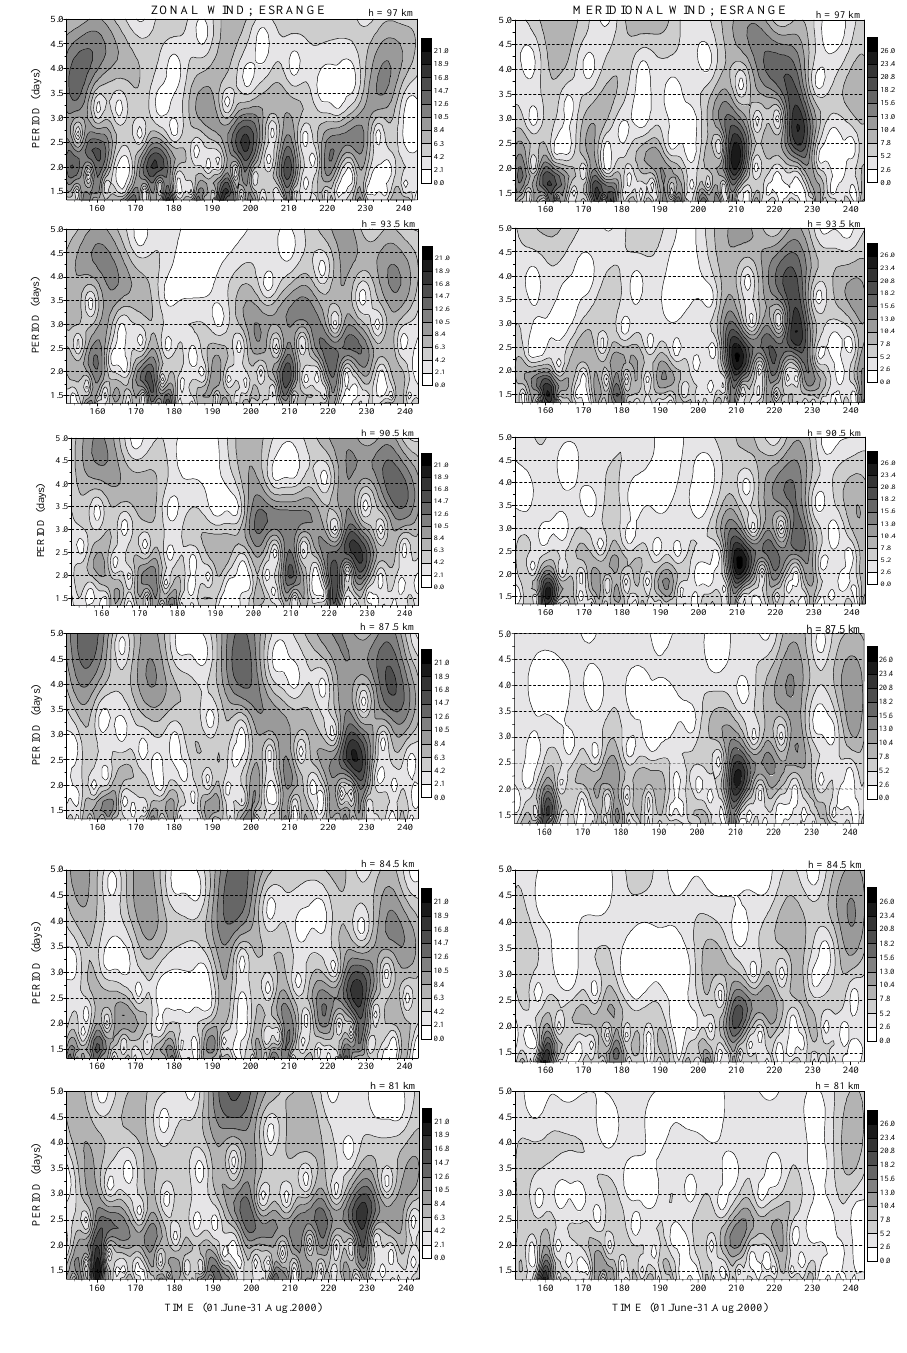
Fig. 4. Morlet wavelet spectra of the wind variations at Esrange.